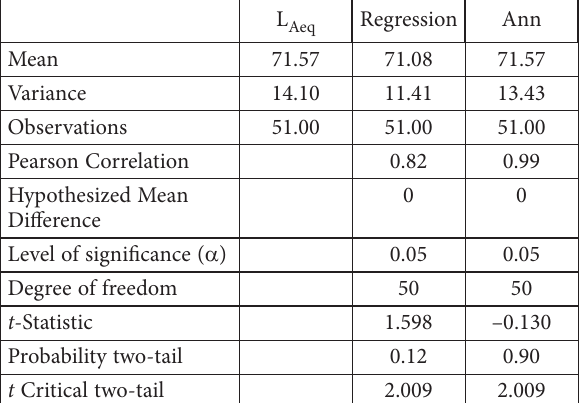
Table 8. Statistical paired t-test results for neural network and